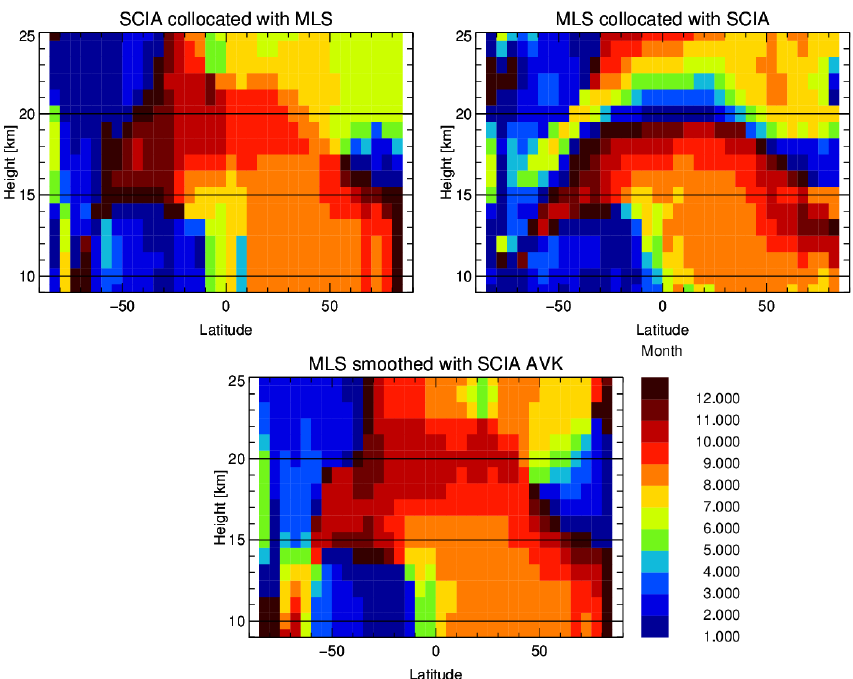
Figure 21. Month with the maximum of the annual cycle for zonal monthly mean collocated data from SCIAMACHY and MLS (unsmoothed and smoothed with SCIAMACHY AVKs). Collocations are found between August 2004 and March